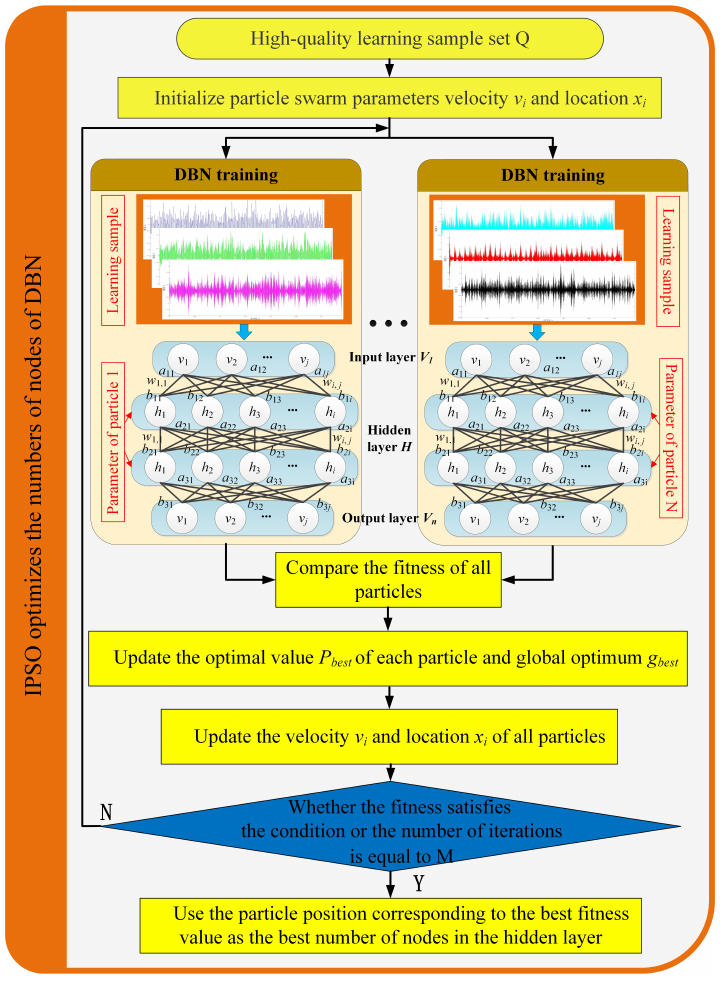
Figure 3. The flow chart of the IPSO algorithm optimizes the number of nodes in the DBN hid- den